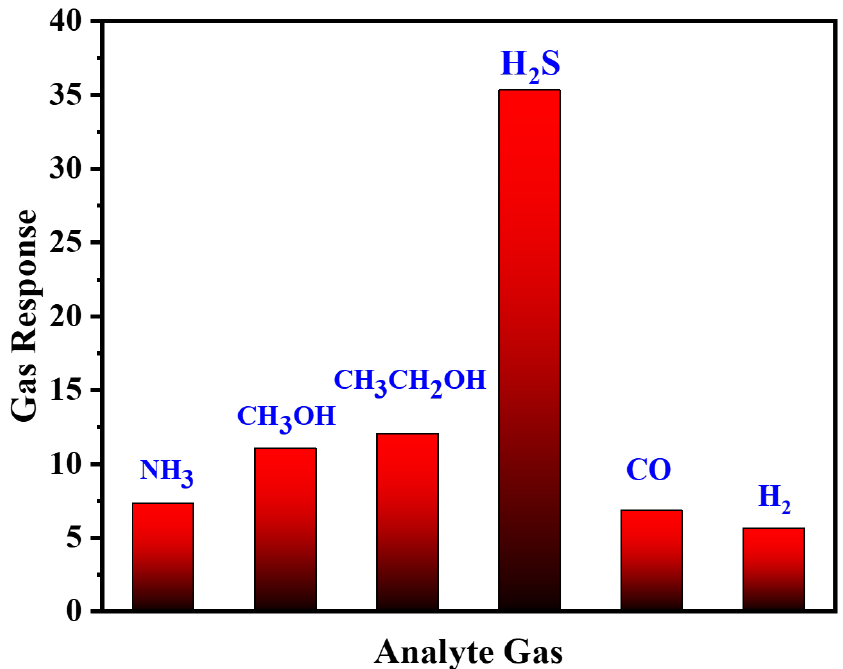
Figure 7. Selectivity studies of the leaf-shaped CuO nanosheets based H 2 S gas